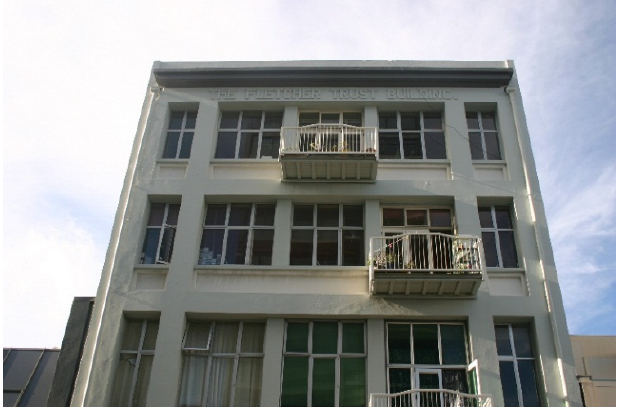
Figure 1. Residential building in College Street. This building has the highest preference rating among the